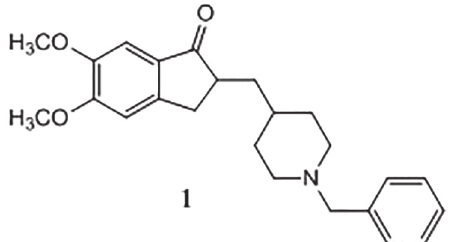
FIGURE 1 - Structural formula of